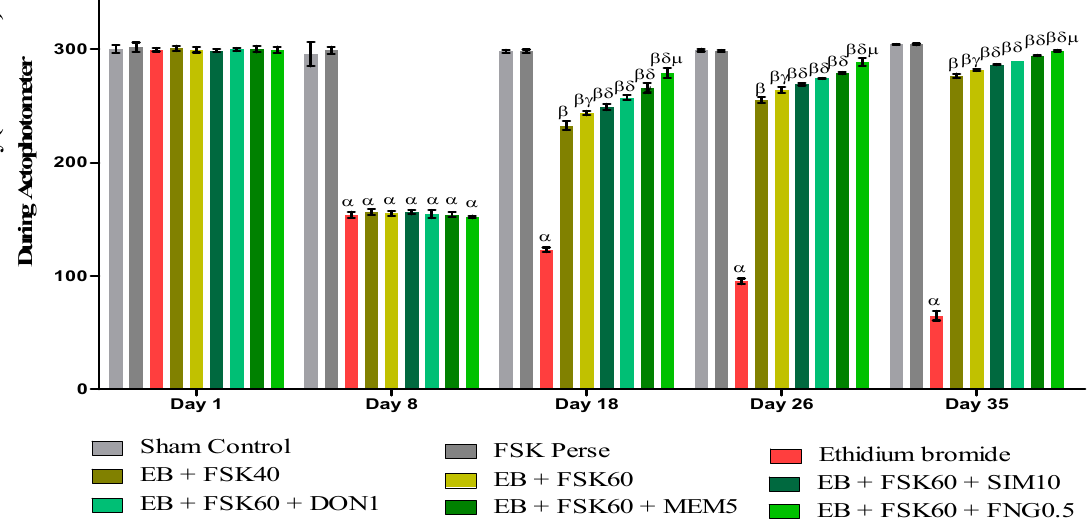
Figure 4. Protective role of FSK during actophotometer in experimental multiple sclerosis rats. Analysis of Variance (ANOVA) with Bonferroni’s post hoc test was used to evaluate the data, which were presented as mean with SD ( n = 6). α EB (p < 0.01) v / s Sham control and FSK40 perse; β EB +